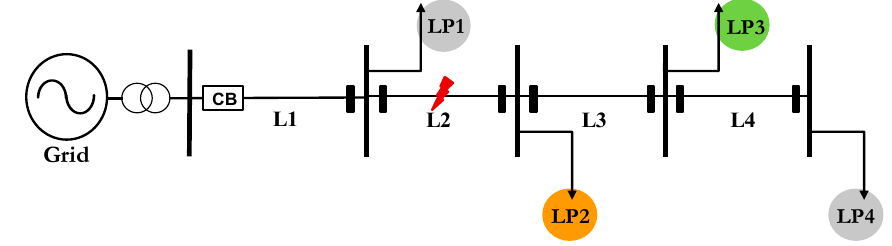
Figure 4. An example of a fault scenario in the test feeder.